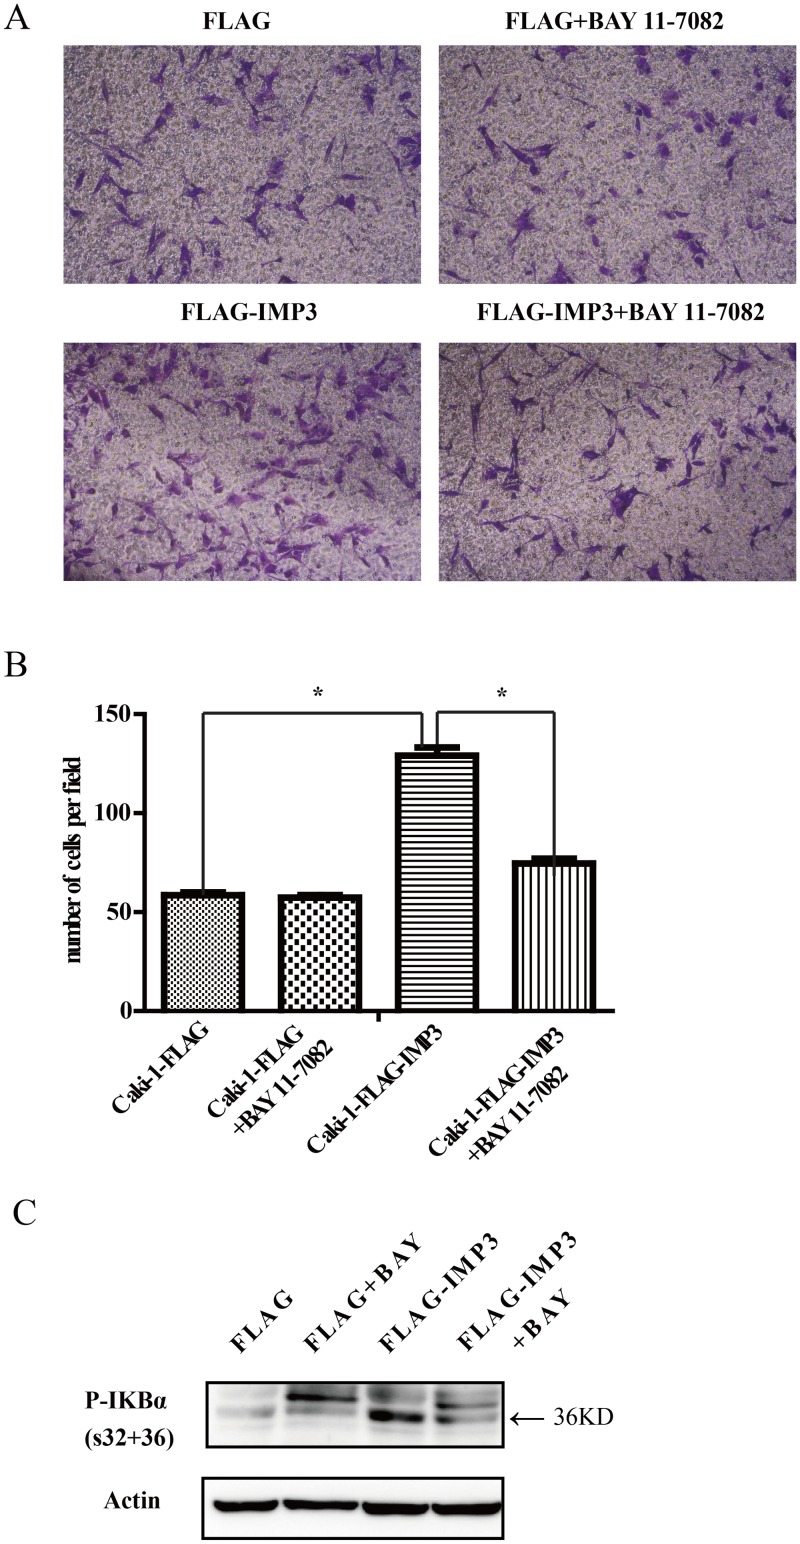
IMP3 promotes RCC cell migration through NF-κB pathway.Caki-1 cells were transfected with FLAG or FLAG-IMP3 vector for 48 h followed by treatment with or without BAY 11–7082 (20 μM) for 1h, and then cells were harvested for Transwell or Western blot assays. Transwell migration assay was used to detect the migration of RCC cells with IMP3 overexpression. Values shown are mean ± SEM of three independent experiments. * p<0.05 (A-B). The expression of P-IκBα was detected by Western blot (C).